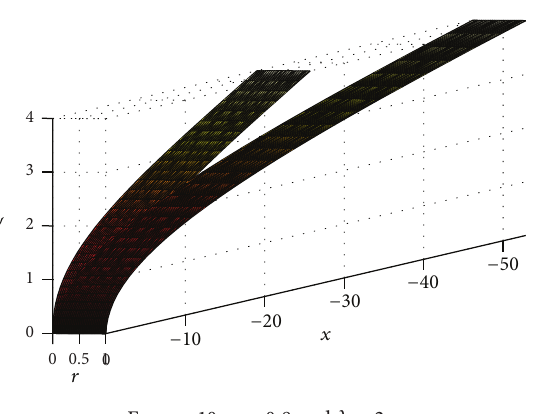
Figure 9: 𝛼 = 0.3 and 𝜆 = 2 .